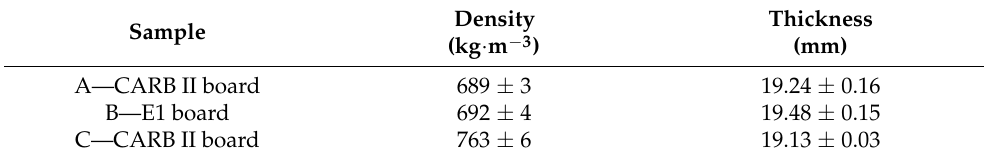
Table 1. Density and thickness of MDF